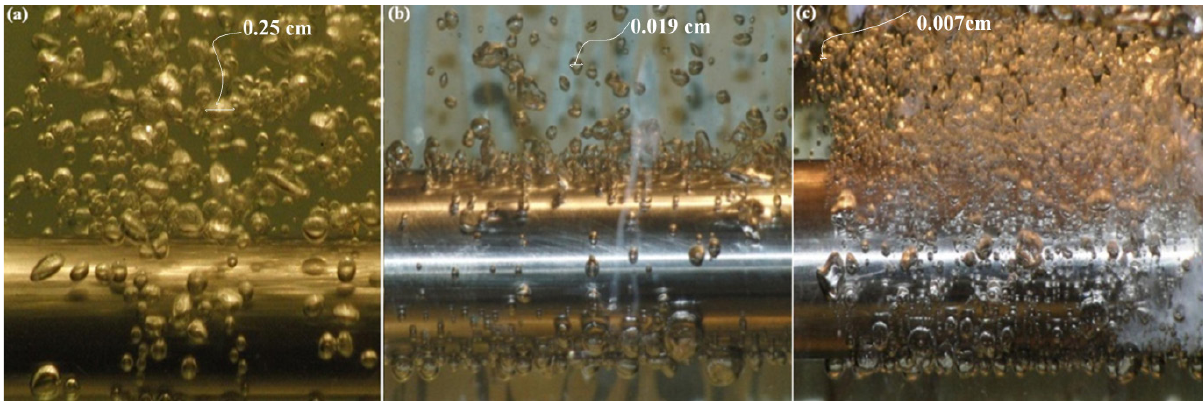
Figure 2: Boiling in a) pure water, b) in the presence of sodium sulfate, and c) in the presence of sodium chloride at a heat flux of 17.356 kW.m -2